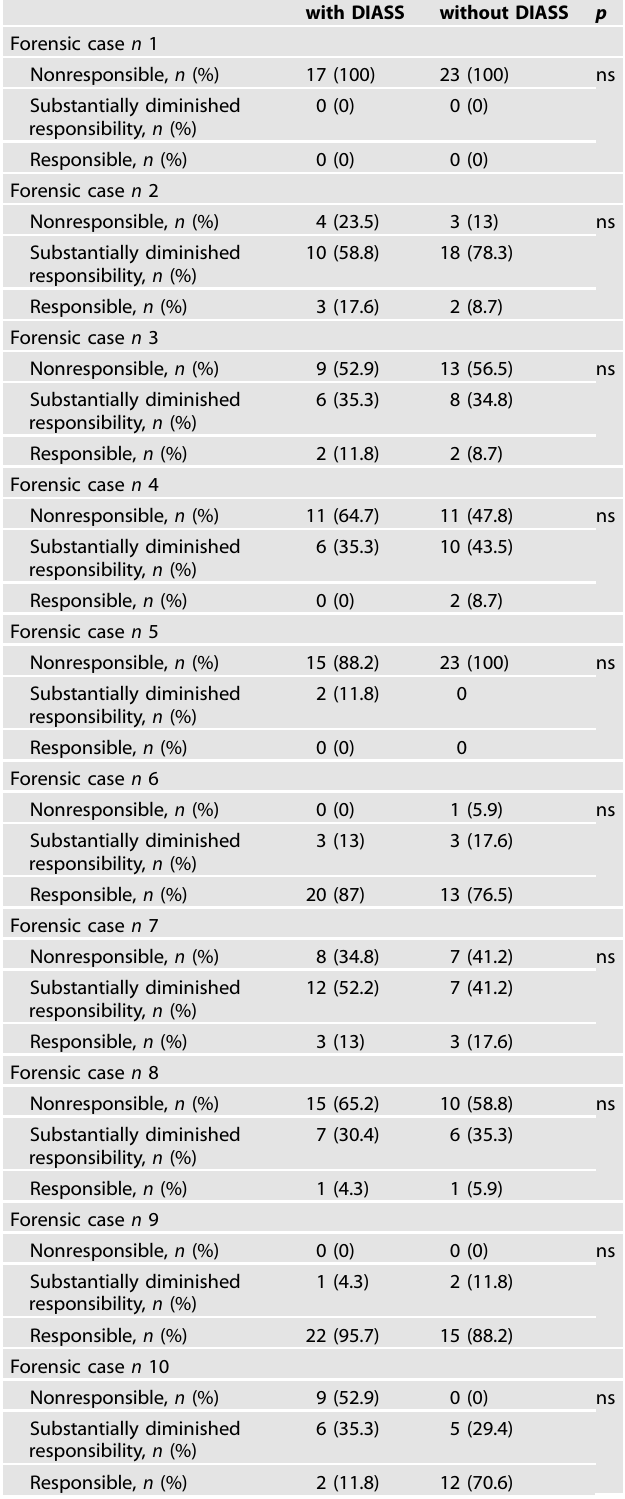
Table 5. Differences in forensic cases evaluation performed with and without the use of the